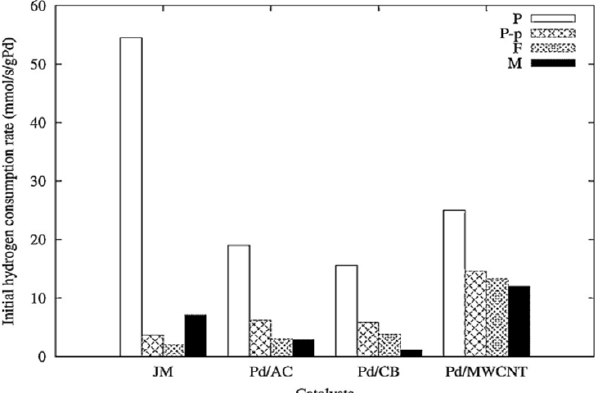
23 of 36 Figure 14. ( a ) Time-dependent UV − vis absorption spectra from 280 to 500 nm and ( b ) the rate kinetics for the conversion of 4-NP in a conventional batch reactor using the AuNCs/CNTs hybrid membrane. ( c ) Breakthrough curves of 4-NP only (without the addition of any NaBH 4 ; the data was obtained at the wavelength of 317 nm). ( d ) Comparison of the UV − vis absorption spectra before and after passing through the AuNCs/CNTs hybrid membrane and the HNO 3 -CNTs membrane [234]. Dip-coating is widely used to prepare macro-structured catalysts for environmental